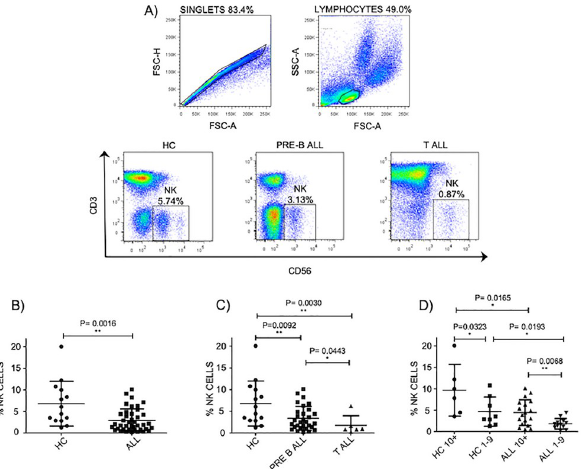
Fig 1. NK cell percentages are abnormal in pediatric ALL patients. A) Gating strategy to obtain NK cell percentages and representative FACS plots. NK cells from pediatric patients or healthy controls were defined by gating on the CD3-CD56+ lymphocyte fraction of PBMCs. B) The Percentages of NK cells in the lymphocyte gates were analyzed in 41 patients with ALL at moment of diagnosis compared to 14 healthy age-matched controls. C) Percentages of NK cells were analyzed according to immunophenotype in 30 pre-B-ALL patients and 6 T-All patients. D) Percentages of NK cells were analyzed according to age in 30 pre-B-ALL patients compared to 14 age-matched controls. Error bars denote standard error of the mean between individuals within group. P values report significance according to U-Mann Whitney Test one-tail. All data were acquired on FACSCanto II (BD bioscience) and analyses with the use of FlowJo 7.6.5 software (Tree Star, Ashland, OR).